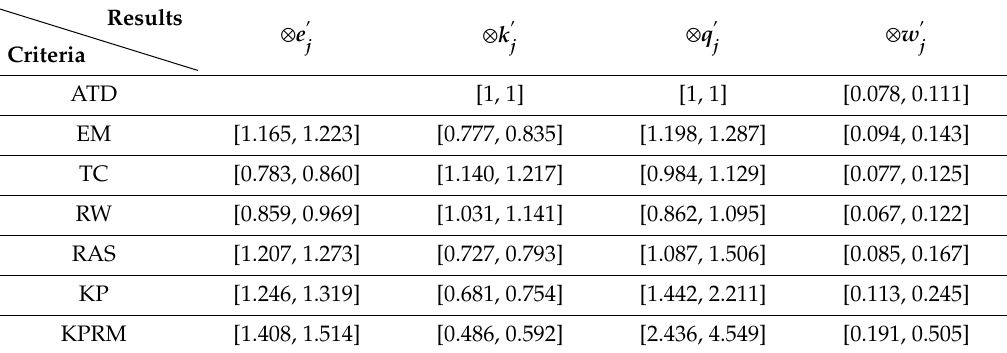
Table 7. The results of inverse PIPRECIA-G.